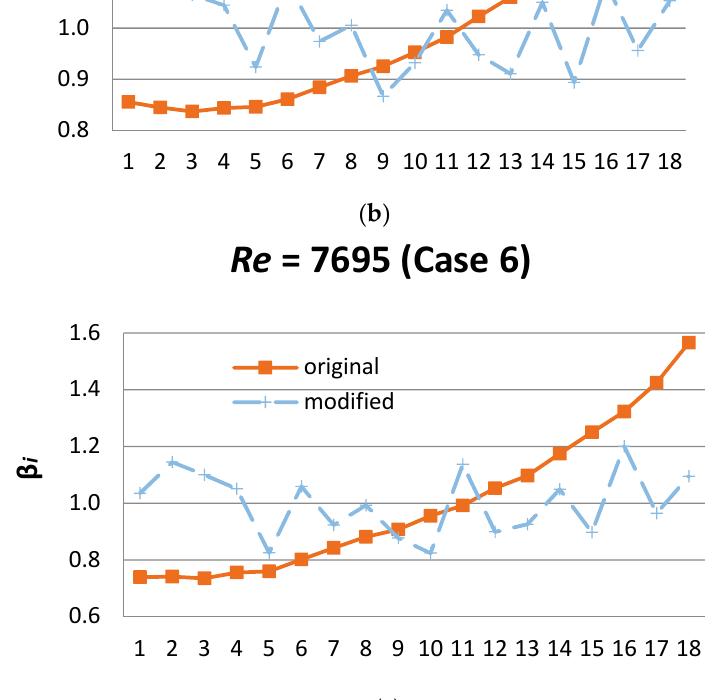
Figure 11. Comparison of flow uniformity metrics in the initial and modified collector geometries. 6. Conclusions Fluid flow distribution in flat plate solar collectors was and continues to be a matter of research for various applications, since the observed non-uniformity of the flow rate distribution among the riser tubes has a detrimental effect in the thermal efficiency of the collector. In the present work, both experimental and numerical studies of the flow uniformity were performed in a forced circulation Z-type flat plate solar collector. Mass flow rate measurements in the riser tubes were performed, utilizing a specially adapted ultrasound instrument for various values of total flow rates in the collector. Appropriate metrics were introduced to quantify flow rate distribution non-uniformity among the risers. By means of a commercial CFD code, laminar and turbulent flow models in different computational grids were tested. Grid-insensitive solutions were obtained and successfully validated against the experiments. It was found that the use of the laminar flow model was sufficient to simulate and reproduce the flow non-uniformity in the flow regime under consideration. Parametric studies for flow conditions outside the experimental window were performed, utilizing the CFD method in order to assess the effect of the Reynolds number in the flow distribution among the riser tubes. It was concluded that the flow non-uniformity among the risers increases with the inlet Reynolds number. In particular, the flow rate is lower than average at the